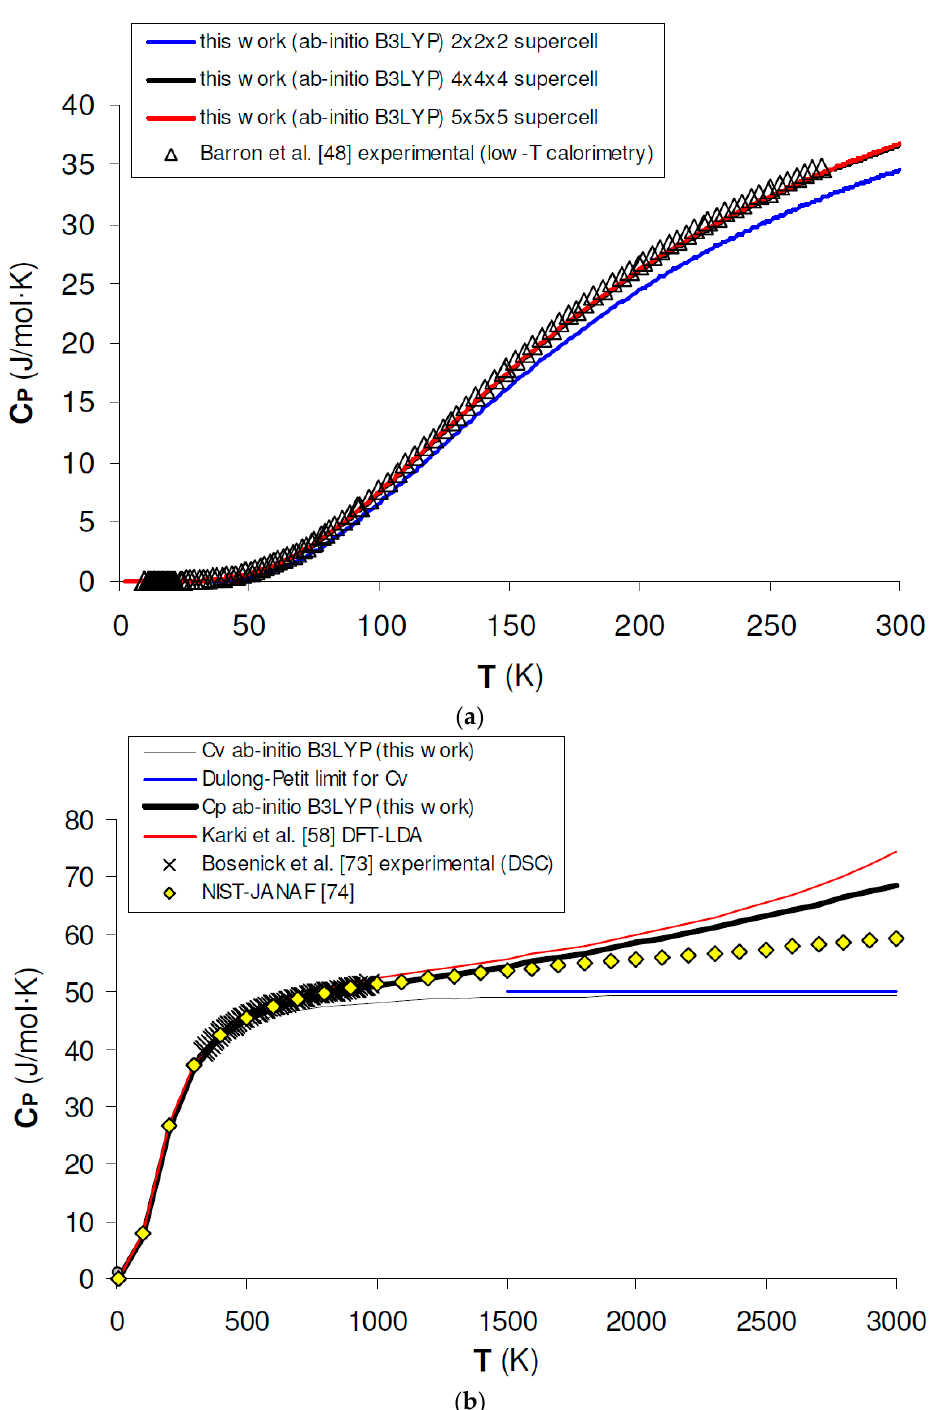
Figure 5. Ab initio B3LYP heat capacity (C V , C P ) of MgO: ( a ) calculated results by phonon dispersion calculation with 2 × 2 × 2, 4 × 4 × 4 and 5 × 5 × 5 supercells as compared to low-T calorimetry experimental data [48]; ( b ) calculated results in the whole T range as compared to experimental data by DSC [73], tabulated values by NIST-JANAF [74] and other ab initio LDA calculations [58].